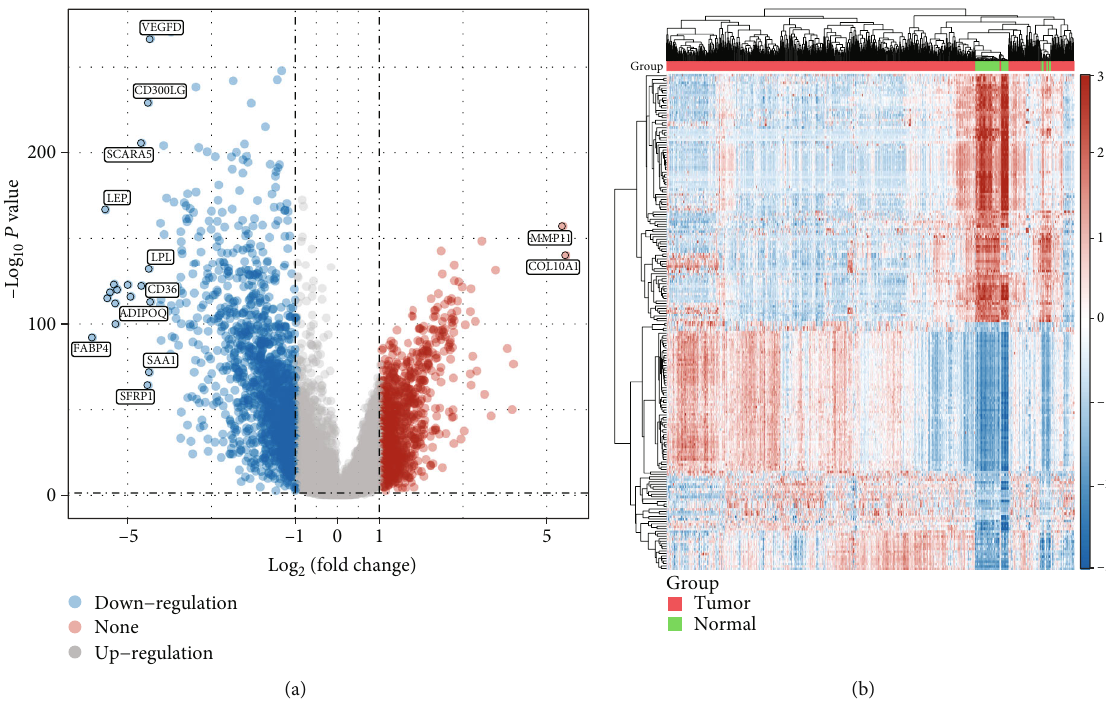
Figure 1: Di ff erentially expressed genes between BC specimens and nontumor specimens, shown in (a) volcano map and (b) heat